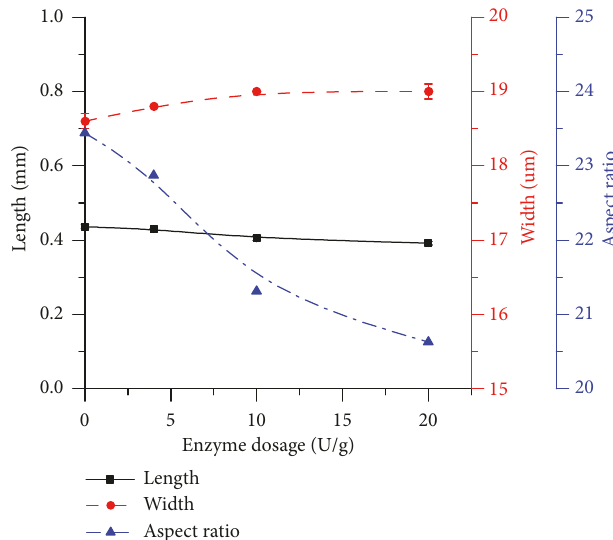
Figure 4: Effect of xylanase treatment on the length and width of refiner mechanical